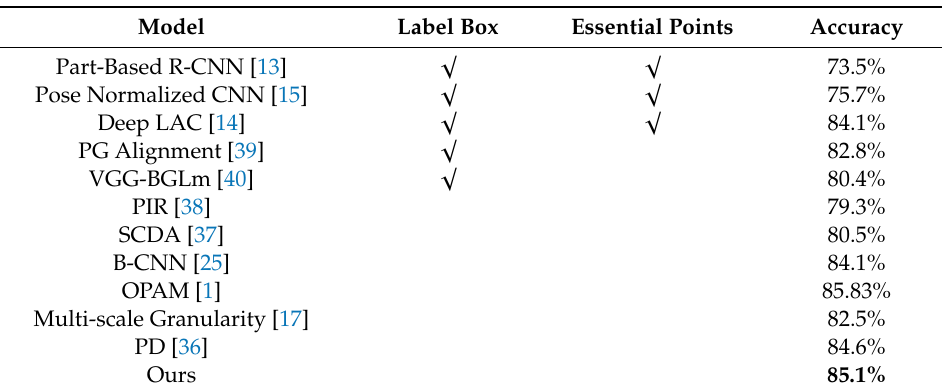
Table 4. Classification accuracy on the CUB 200-2011